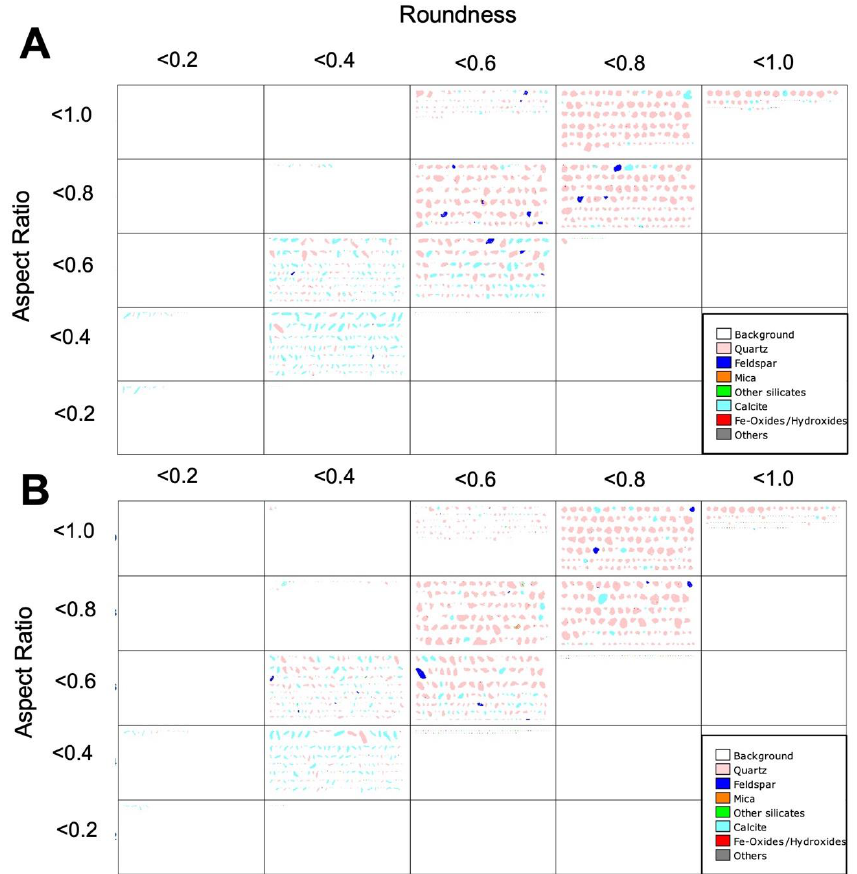
Figure 10. Image showing the mineralogy and relative roundness and aspect ratios of the different sizes of sand particles from the biological sand reactors of core samples taken at year 0 ( A ) and year 3 ( B ).